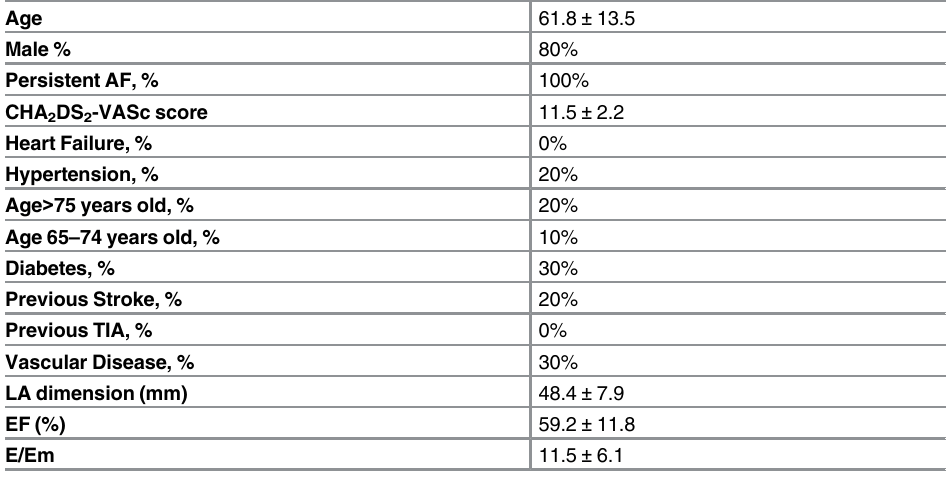
Table 1. Patients